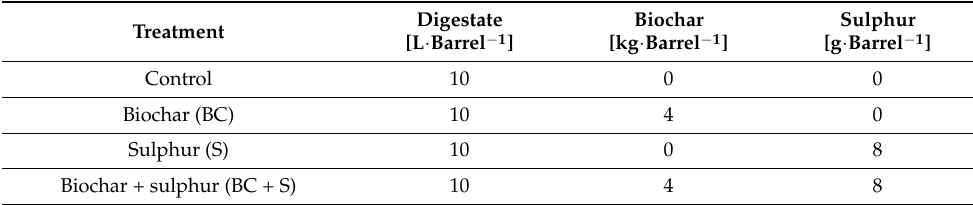
Table 1. Activation doses.